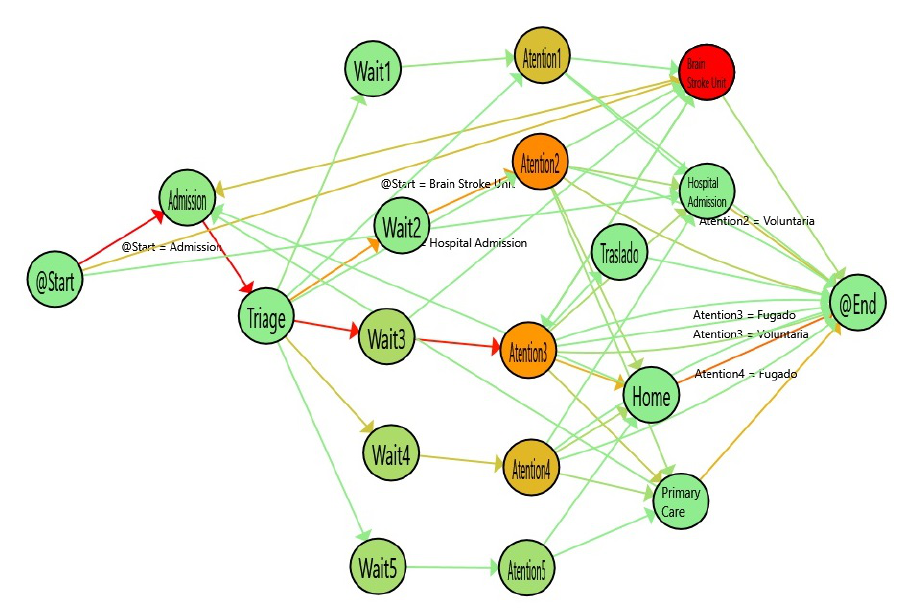
Figure 8. Flow for single triage (from January to March 2017). The colors in the nodes represent the average time spent on each activity and the colors of the edges represent the number of patients that followed this path.